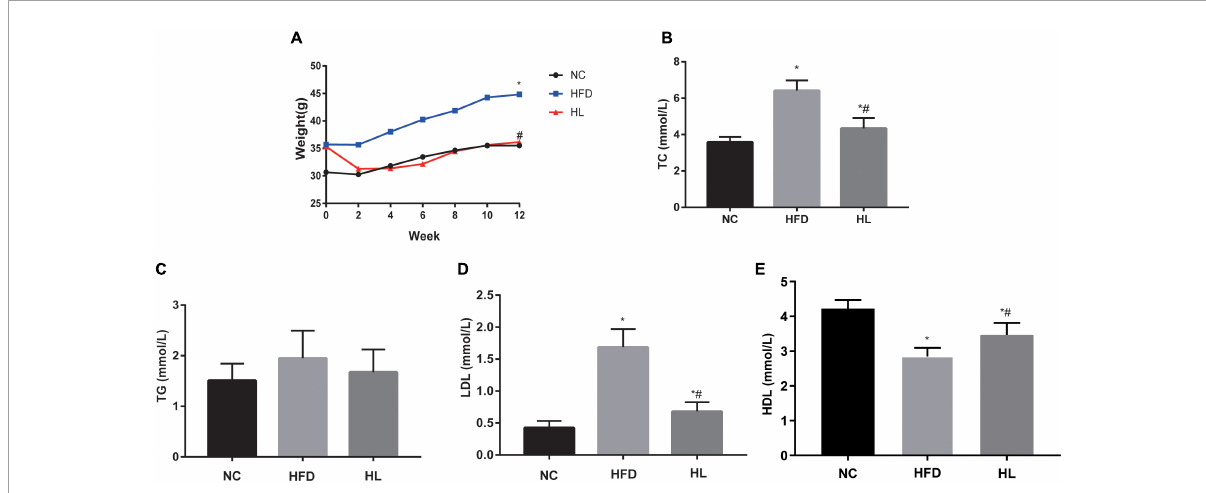
FIGURE1 Liraglutide attenuated weight gain and blood lipid profile. (A) Body weight. (B) Total cholesterol (TC) levels. (C) Triglyceride (TG) levels. (D) Low-density lipoprotein (LDL) cholesterol levels. (E) High-density lipoprotein (HDL) cholesterol levels. Data are presented as the mean ± SEM. * p < 0.05 vs. NC group; # p < 0.05 vs. HFD